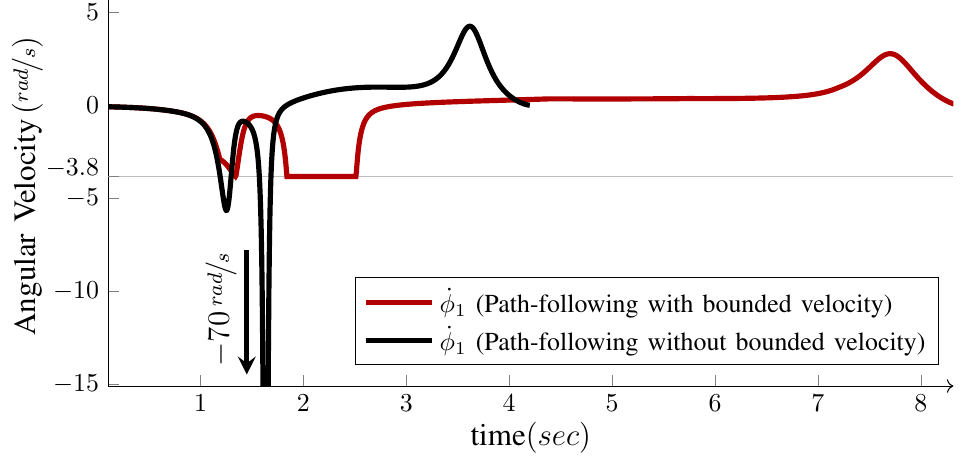
Figure 6. First wheel angular velocity ˙ φ 1 , with and without bounded